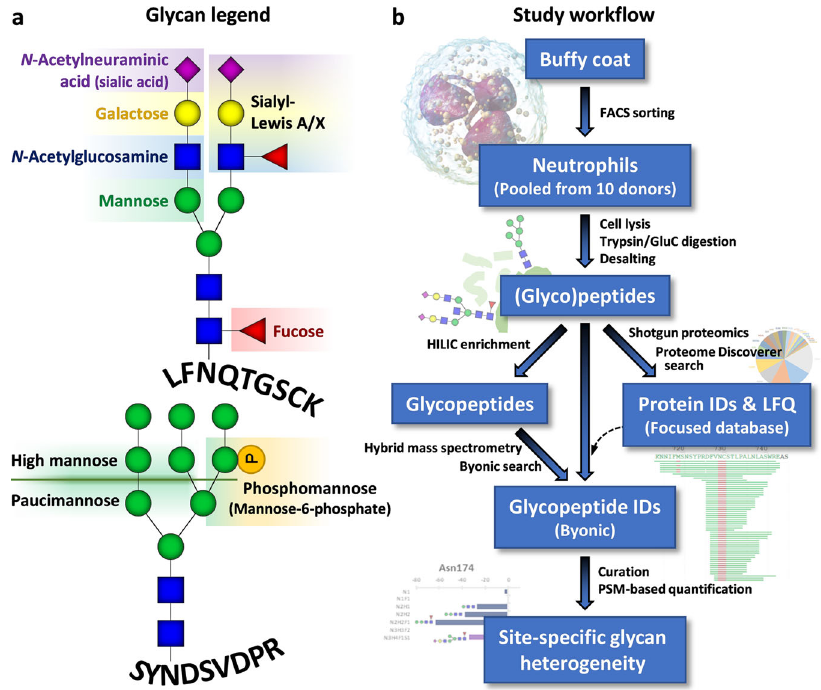
Fig. 1 Background information for glycan nomenclature and study design. a Annotations is used to describe glycan compositions. Monosaccharides are represented as: fucose (Fuc; red triangle), mannose (Man; green circle), galactose (Gal; yellow circle), N -acetylglucosamine (GlcNAc; blue square), N -acetylneuraminic acid (NeuAc; dark magenta diamond), and phosphomannose (phospho; orange circle). b Scheme of the experimental work fl ow. Neutrophils acquired by fl ow cytometry of buffy coats were pooled from 10 independent, presumably healthy, donors. The cells were disrupted, the released proteins digested, and the peptides were desalted by reversed-phase (RP) solid-phase enrichment (SPE). The resulting (glyco)peptides were then either further enriched by hydrophilic-interaction liquid chromatography (HILIC) SPE before mass spectrometry (MS) analysis, or directly analysed by MS without enrichment. Results from shotgun proteomics (desalting-only) were used for the identi fi cation and quanti fi cation (LFQ) of the proteins, whereas the glycoproteomics data resulting from both desalting-only and desalting + HILIC were used for identi fi cation and quanti fi cation of the